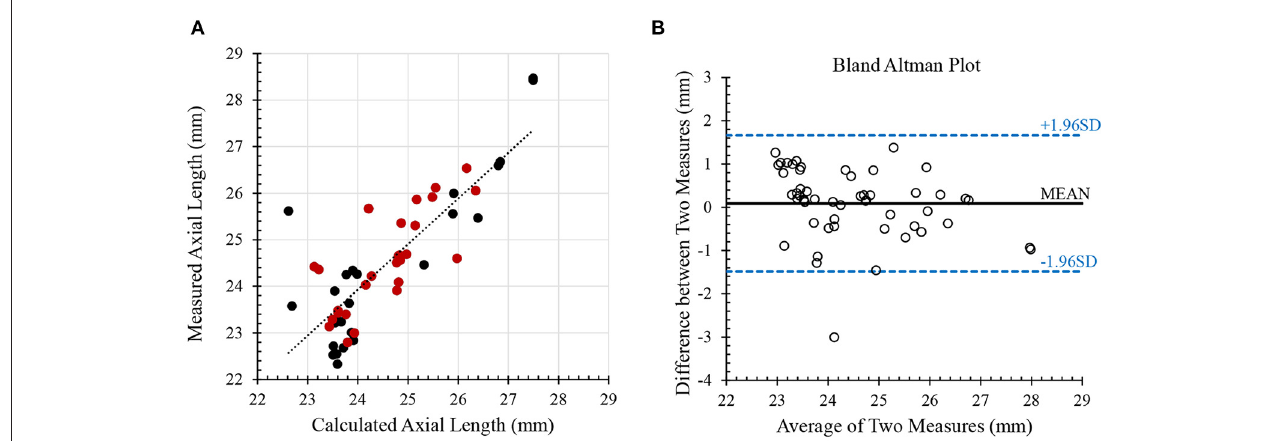
FIGURE 2 | Validation of axial length. (A) the calculated axial length from Spectralis was strongly correlated with the measured axial length from ANTERION. Red dots indicate healthy subjects and black dots indicate pathological subjects ( n = 53; Pearson R = 0.83; p < 0.00001) (B) Bland-Altman plot for comparing calculated and measure axial lengths.